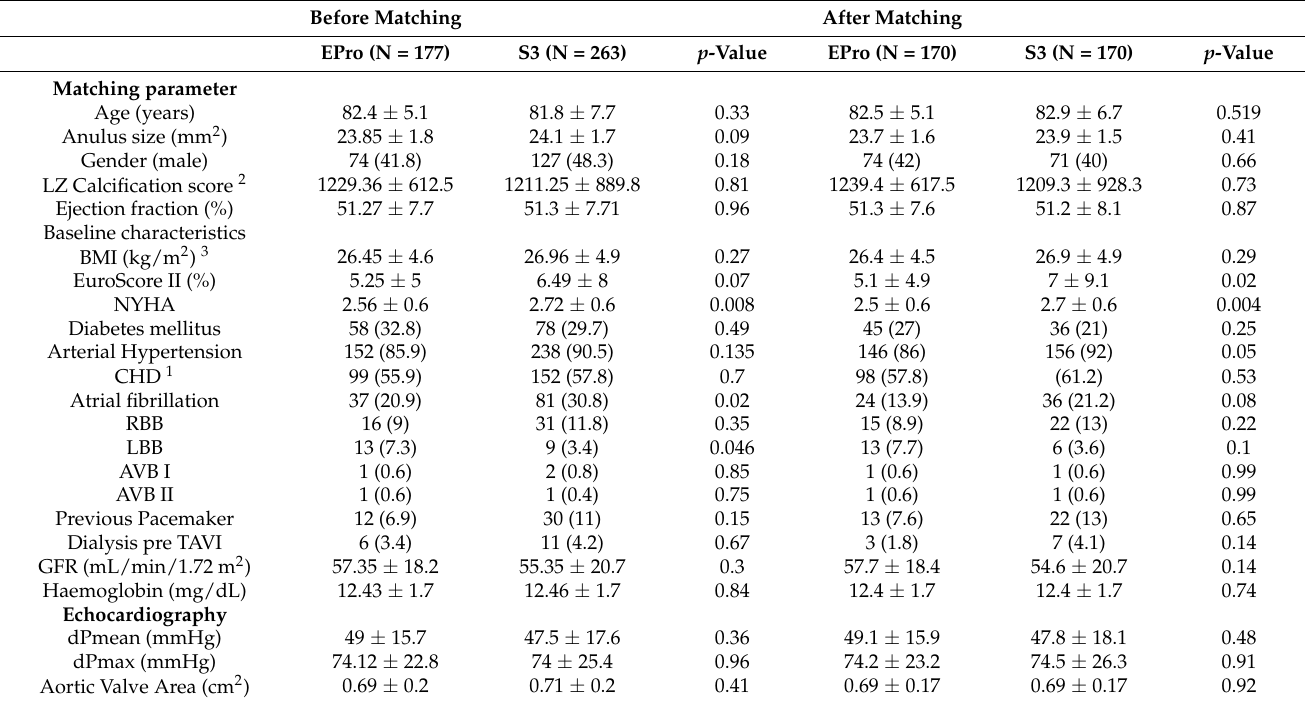
Table 1. Characteristics of the matched study population grouped by patient receiving either an Evolut Pro or Sapien 3 prosthesis.